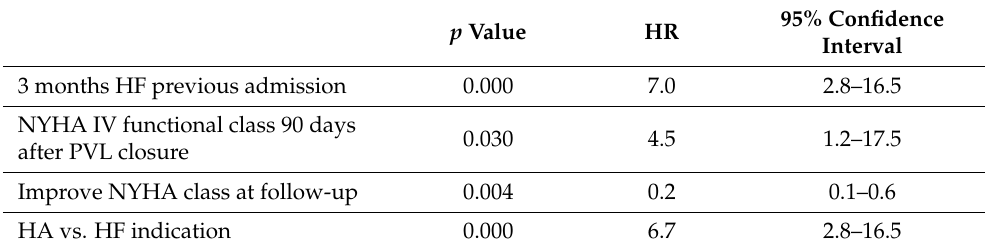
Table 6. Predictors of death during long-term follow-up.